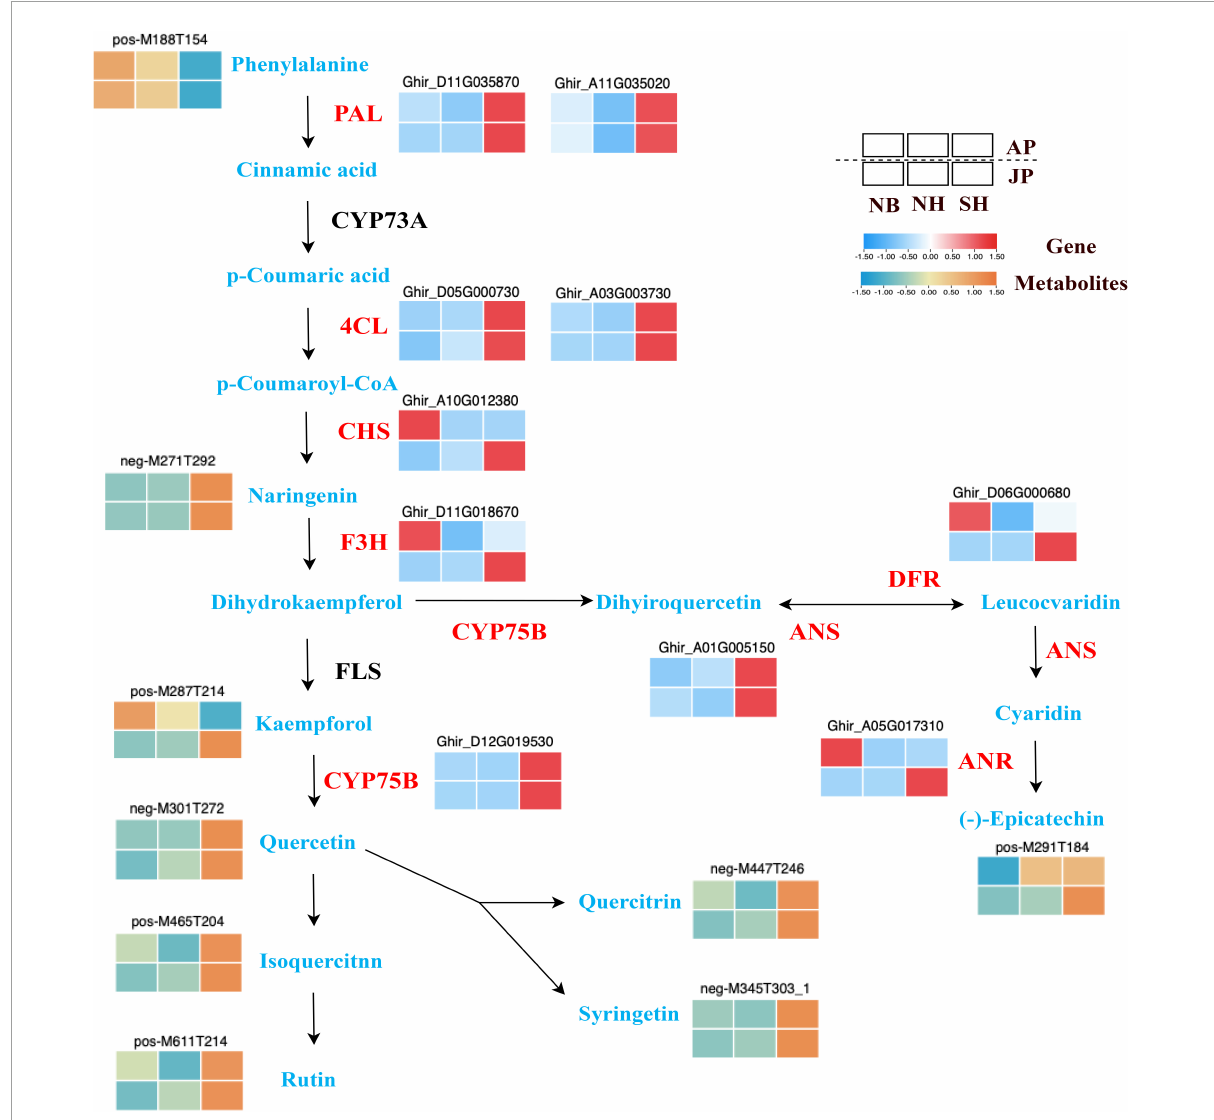
FIGURE7 Different expressions of structural genes (red) and metabolites in flavonoid biosynthesis pathway. Red and blue blocks represent upregulation and downregulation of expression, respectively. Abbreviations: PAL, phenylalanine ammonia lyase; 4CL, 4-eoumarate coenzyme A ligases; CHS, chalcone synthase; F3H, flavonoid 3-hydroxylase; CYP75B, cytochromes P450; ANS, anthocyanidin synthase; DFR, dihydroflavonol 4-reductase; ANR, anthocyanidin